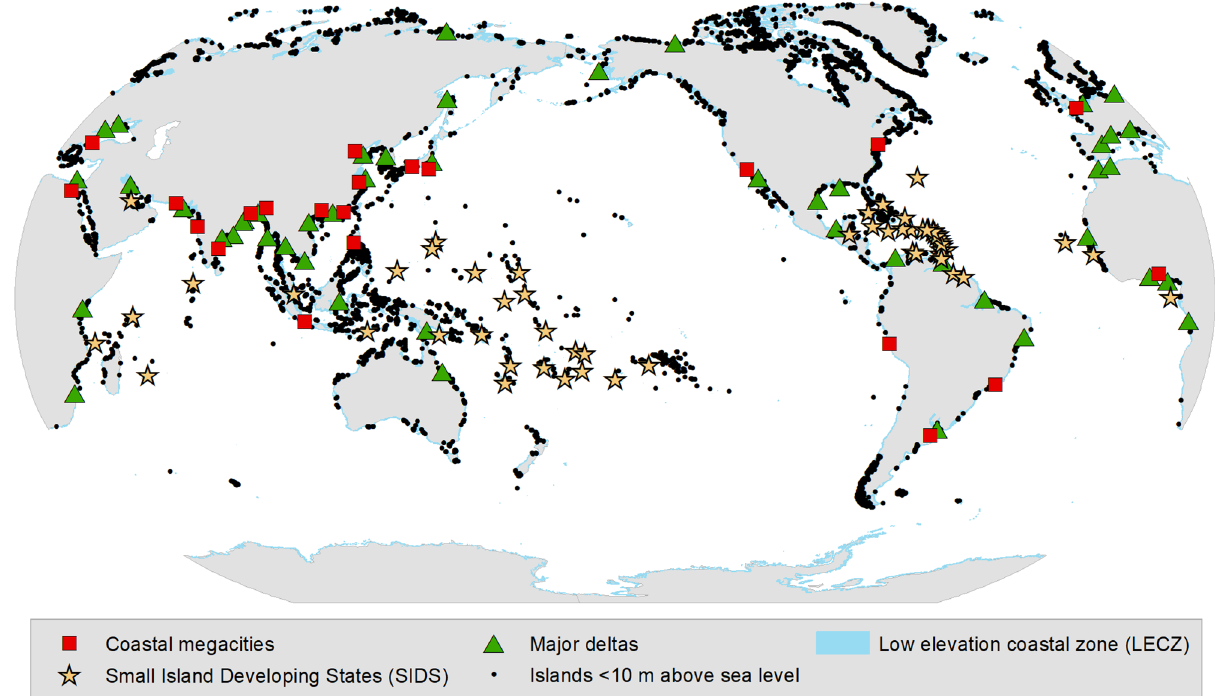
noaa. gov/ cgi- bin/ iso? id= gov. noaa. ngdc. mgg. dem: 280), islands with a maximum elevation of 10 m above sea level (black dots), Small Island Developing States (yellow stars; Source: http:// unohr lls. org/ about- sids/),